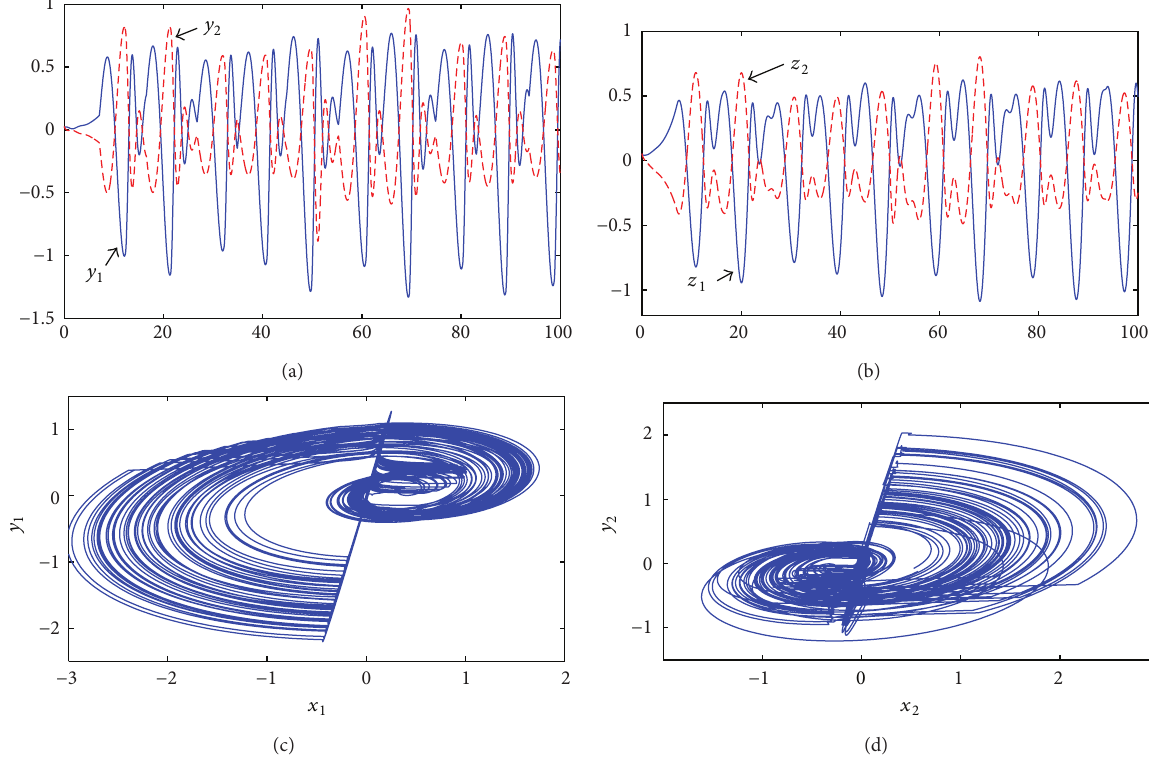
Figure 6: ((a), (b)) the 𝑥 1 - 𝑦 1 and 𝑥 2 - 𝑦 2 projections, and ((c), (d)) the 𝑥 , 𝑦 , and 𝑧 responses when {𝛼,𝛽,𝛾,𝑎 1 , 𝑏 1 , 𝑐 1 , 𝑎 2 , 𝑏 2 ,𝑐 2 } = {0.95, 0.95, 0.95, 4,1, 0.65, 4, 1, 0.65} for Case E.